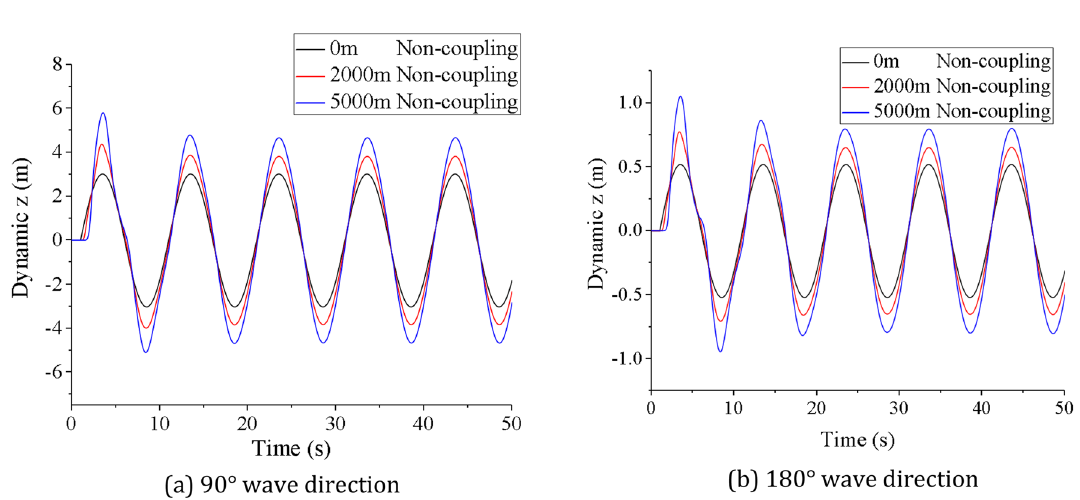
Figure 9. Longitudinal vibration displacements of lifting pipe (created by Origin 2017 software, URL: https:// www. origi nlab.